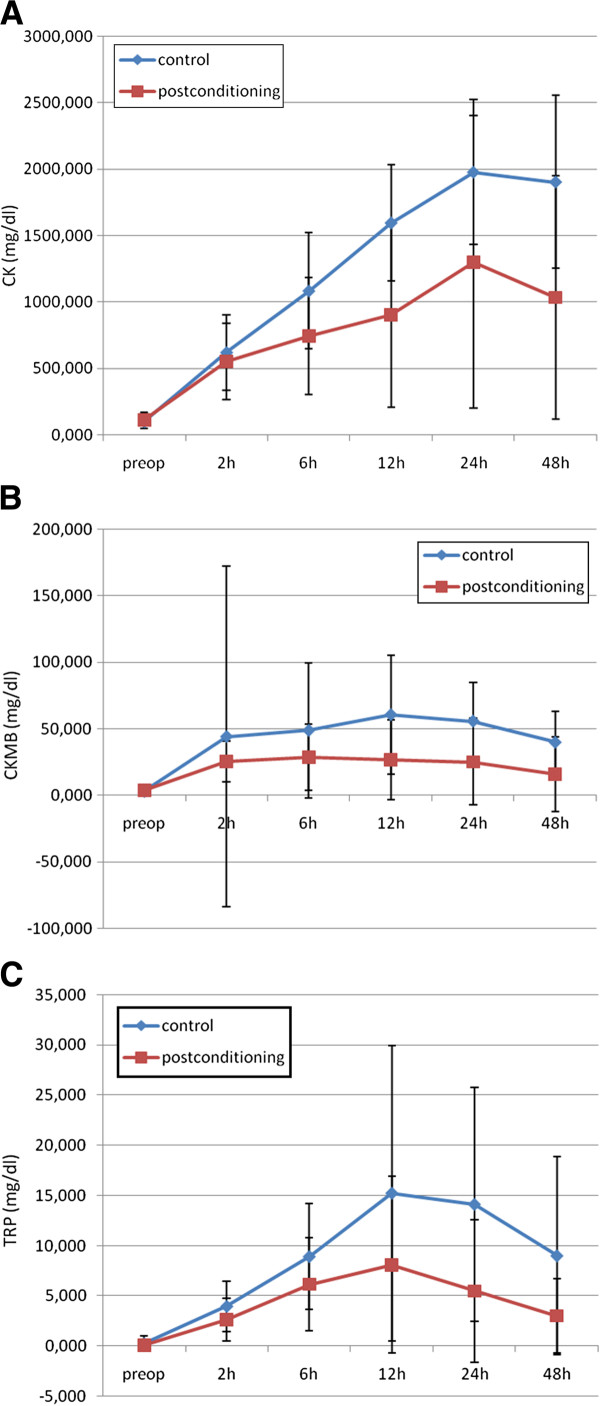
The Kinetics of Cardiac Biomarkers.A; Time Course of Creatine Kinase (CK). Preoperative CK values were statistically insignificant for the control and postconditioning groups. Postoperative 2 hour point, CK values were similar. After 6 hour, CK levels for the MMPOC group and Control group began to depart and this significant difference continued to the 12 hour, 24 hour and 48 hour after the procedure. B; Time Course of Creatine Kinase Myocard-Brain (CK-MB). Preoperative CK-MB values were statistically insignificant for the control and postconditioning groups. Postoperative 2 hour point, CK-MB values for the two groups were began to differentiated statistically. CK-MB levels for the MMPOC and Control group were statistically significant for the 6 hour, 12 hour, 24 hour, and 48 hour time points. C; Time Course of Troponin-I (TnI). Preoperative TnI values were statistically insignificant for the control and postconditioning groups. Postoperative 2 hour point, TnI values were similar. After 6 hour, TnI levels for the MMPOC group and Control group began to depart and this significant difference continued to the 12 hour, 24 hour and 48 hour after the procedure. Blue line: Control, Red line: MMPOC.